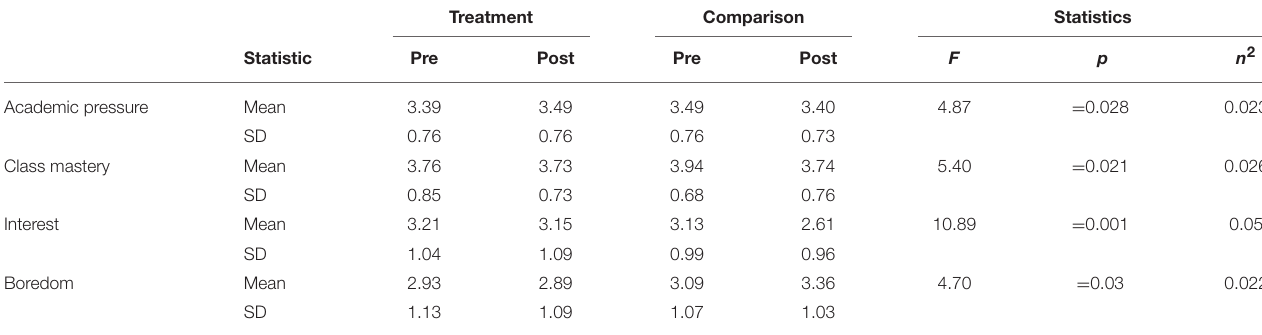
TABLE 1 | Descriptive statistics academic pressure, class mastery, interest, and boredom (pre to post) between groups ( N = 237).